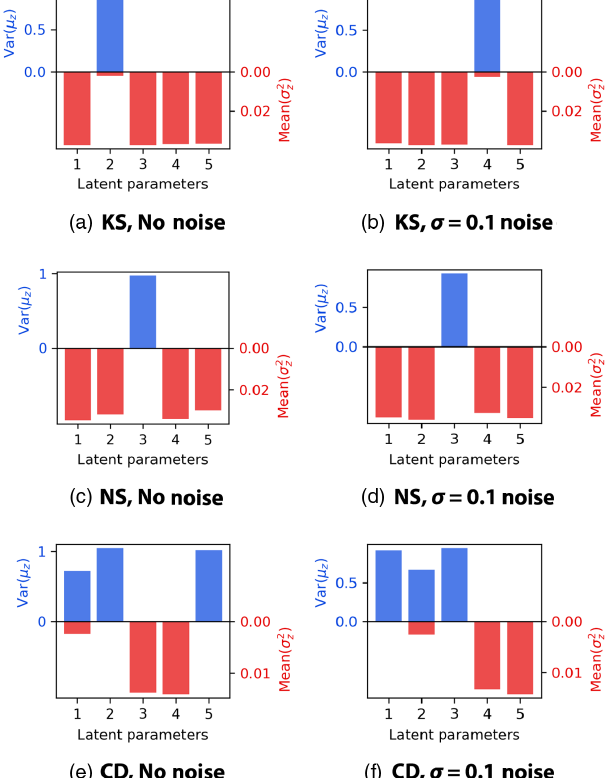
FIG. 2. Identification of relevant latent parameters: the variance of μ (blue) and mean of σ 2 (red) for the five latent parameters in z z the models trained on the (a),(b) 1D Kuramoto-Sivashinsky (KS), (c),(d) 1D nonlinear Schrödinger (NS), and (e),(f) 2D convection- diffusion (CD) datasets both with and without added noise. In each case, the model has correctly identified the number of relevant parameters (one for the Kuramoto-Sivashinsky and nonlinear Schrödinger datasets, and three for the convection- diffusion dataset), which are characterized by high variance in μ z and a low mean σ 2 . These relevant latent parameters correspond z to interpretable physical parameters that parametrize the dynam- ics of the system. The other latent parameters with near zero variance in μ and high mean σ 2 have collapsed to the prior and z z are noninformative. Note that while one would expect these 1 , the actual extracted σ 2 collapsed parameters to have σ 2 for z ¼ z the collapsed noninformative parameters is less than one. This is an artifact of evaluating the model on a larger system size and longer time series than the cropped patches used during training (see Appendix F for